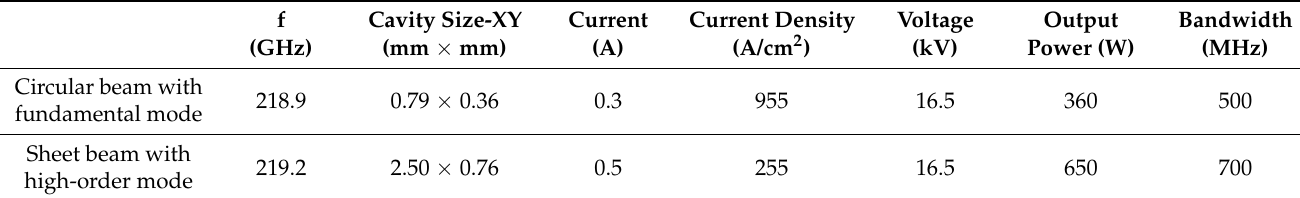
Table 4. The characteristic parameters of the high-order mode EIK and fundamental mode